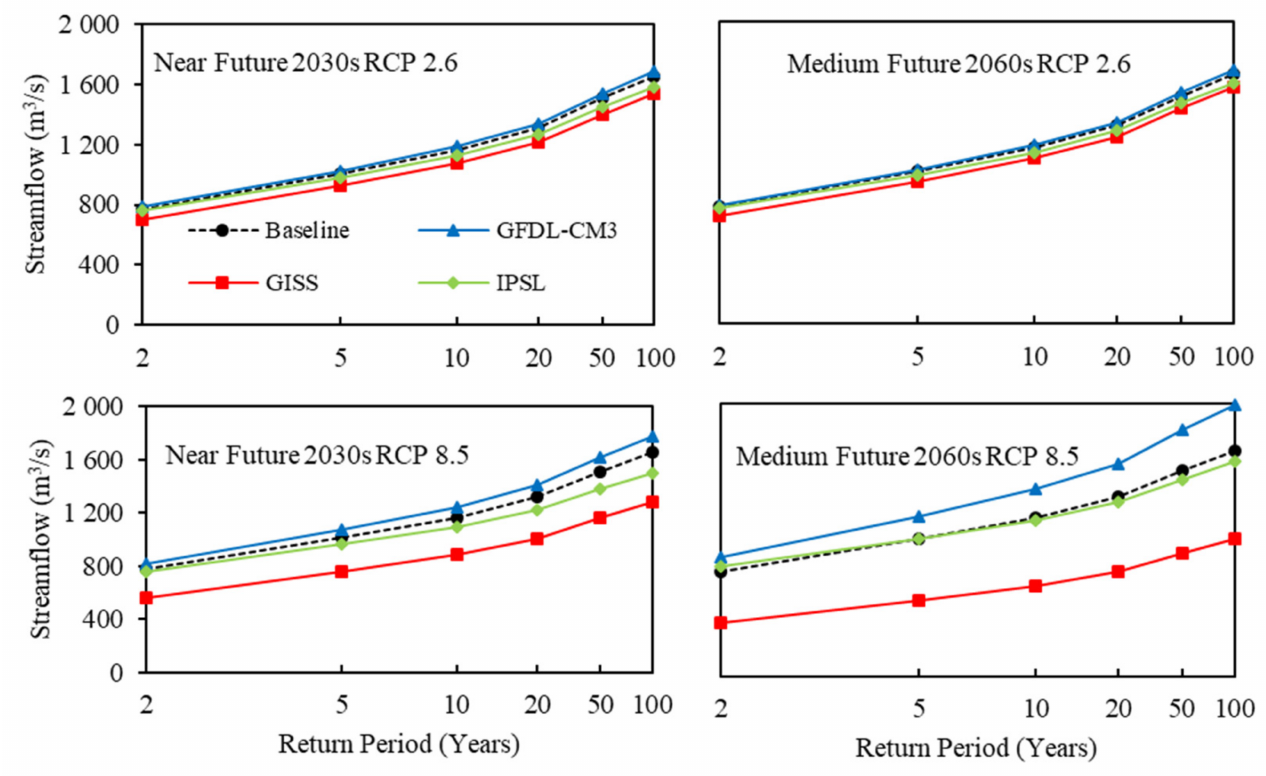
Figure 7. One-day maximum flow frequency